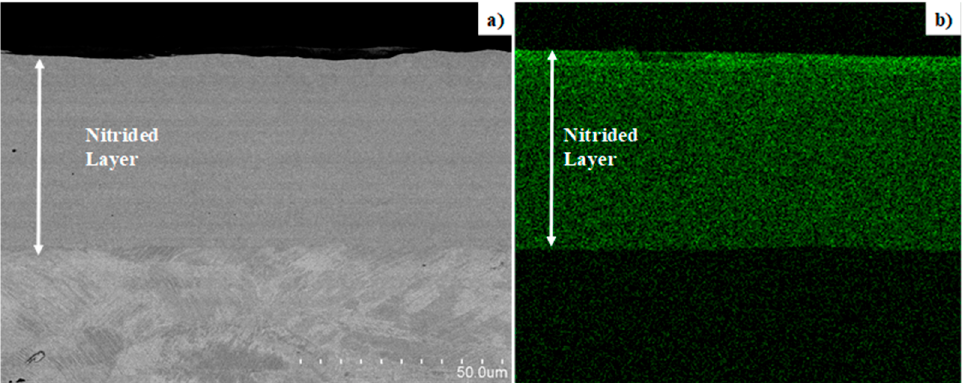
Figure 8. SEM image on the cross-section of nitrided AISI304 substrate at 623 K for 14.4 ks and its nitrogen mapping. ( a ) SEM image on the cross-section, and ( b ) nitrogen solute mapping.